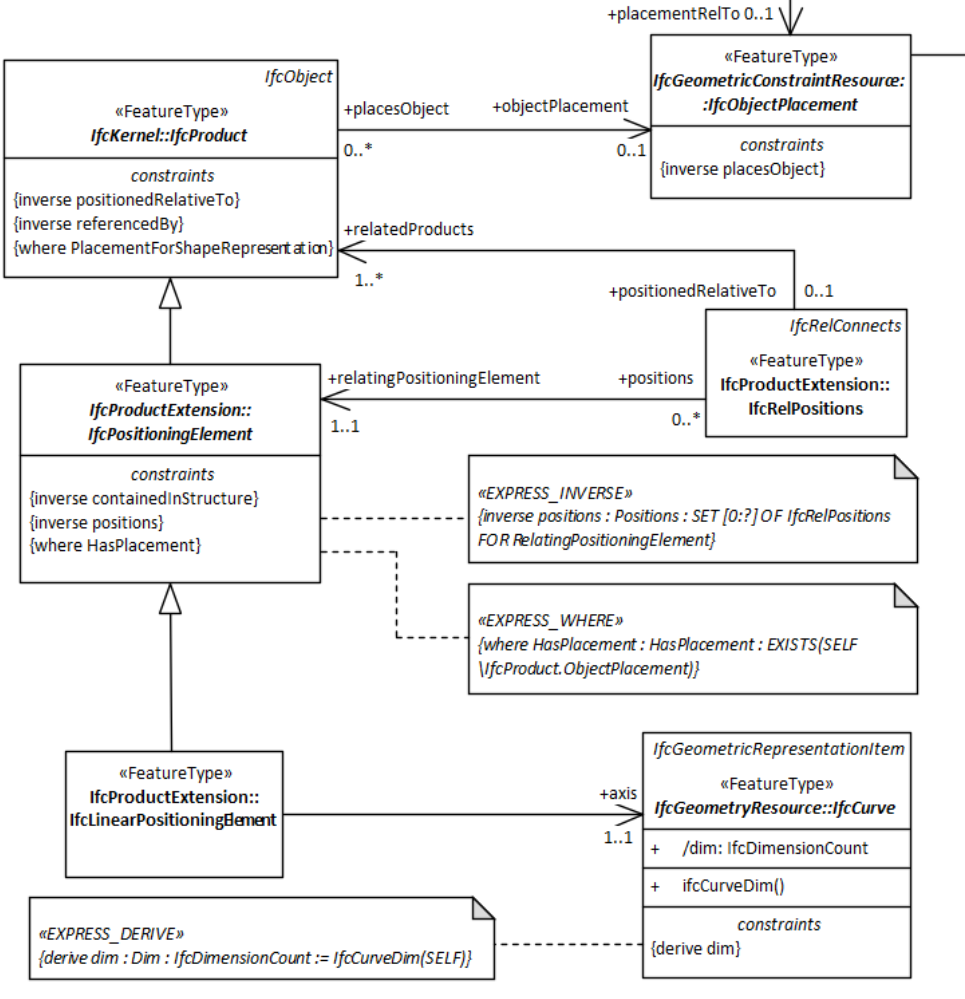
Table 8. Conversion pattern for IFC EXPRESS constraints. UML Constraint Property